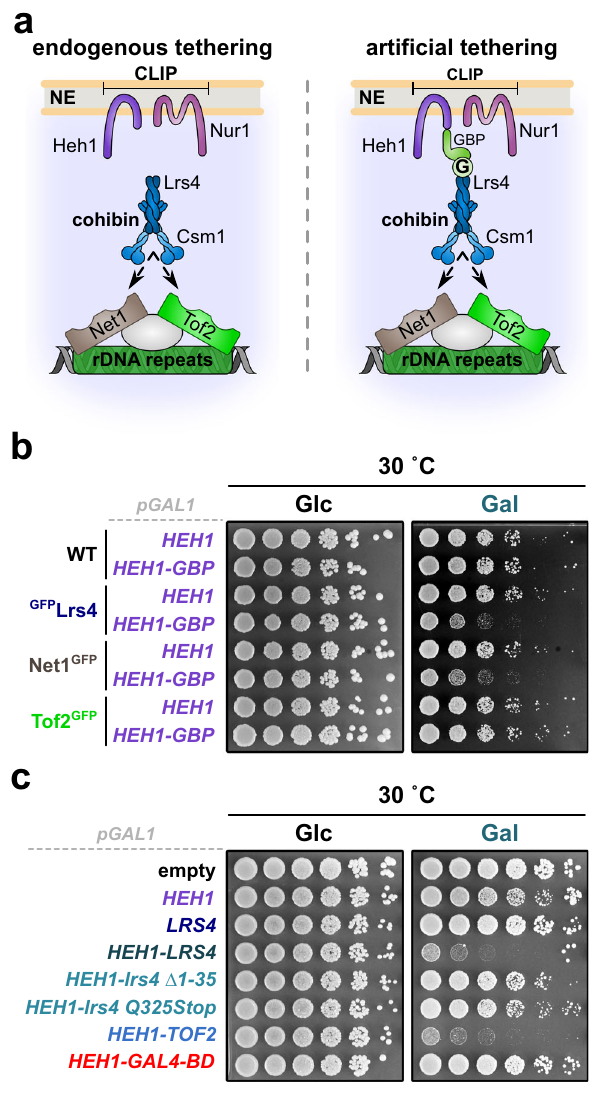
Fig. 1 Constitutive perinuclear tethering of rDNA is detrimental. a Scheme of synthetic rDNA tethering through the expression of GFP- and GBP-fusion proteins. Lrs4 binds ribosomal repeats through interaction with the rDNA-bound proteins Net1 or Tof2. G, GFP. b Fivefold serial dilutions of WT, GFP Lrs4, Net1 GFP , and Tof2 GFP cells transformed with empty vector or a plasmid bearing HEH1 fused to GFP-binding protein ( GBP ). c Fivefold serial dilutions of WT cells transformed with empty vector or plasmids bearing the indicated GFP-tagged fusion proteins. b , c Cells were spotted and grown on selective media with 2% glucose (control, Glc) or 2% galactose (induction, Gal) at 30 °C for 3 days. All constructs contain the galactose- inducible GAL1